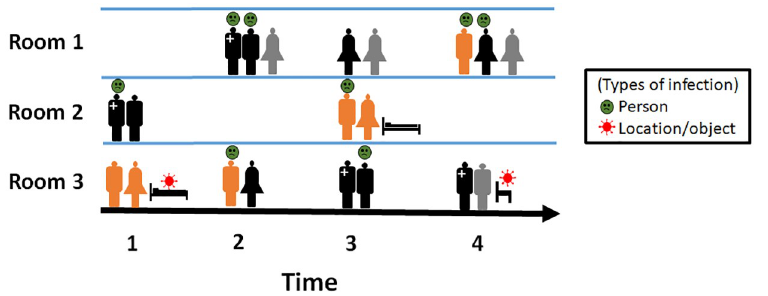
Fig 1. Visualization of a possible HAI spread. The only healthcare worker in the example is marked with a ‘+’ sign. The rest of the humans are patients and visitors. Each individual is assigned a unique combination of color and silhouette pair. Infected humans are indicated by the green emoji and contaminated locations are indicated by the bacteria emoji. As human agents move through various locations, they infect other agents and contaminate the